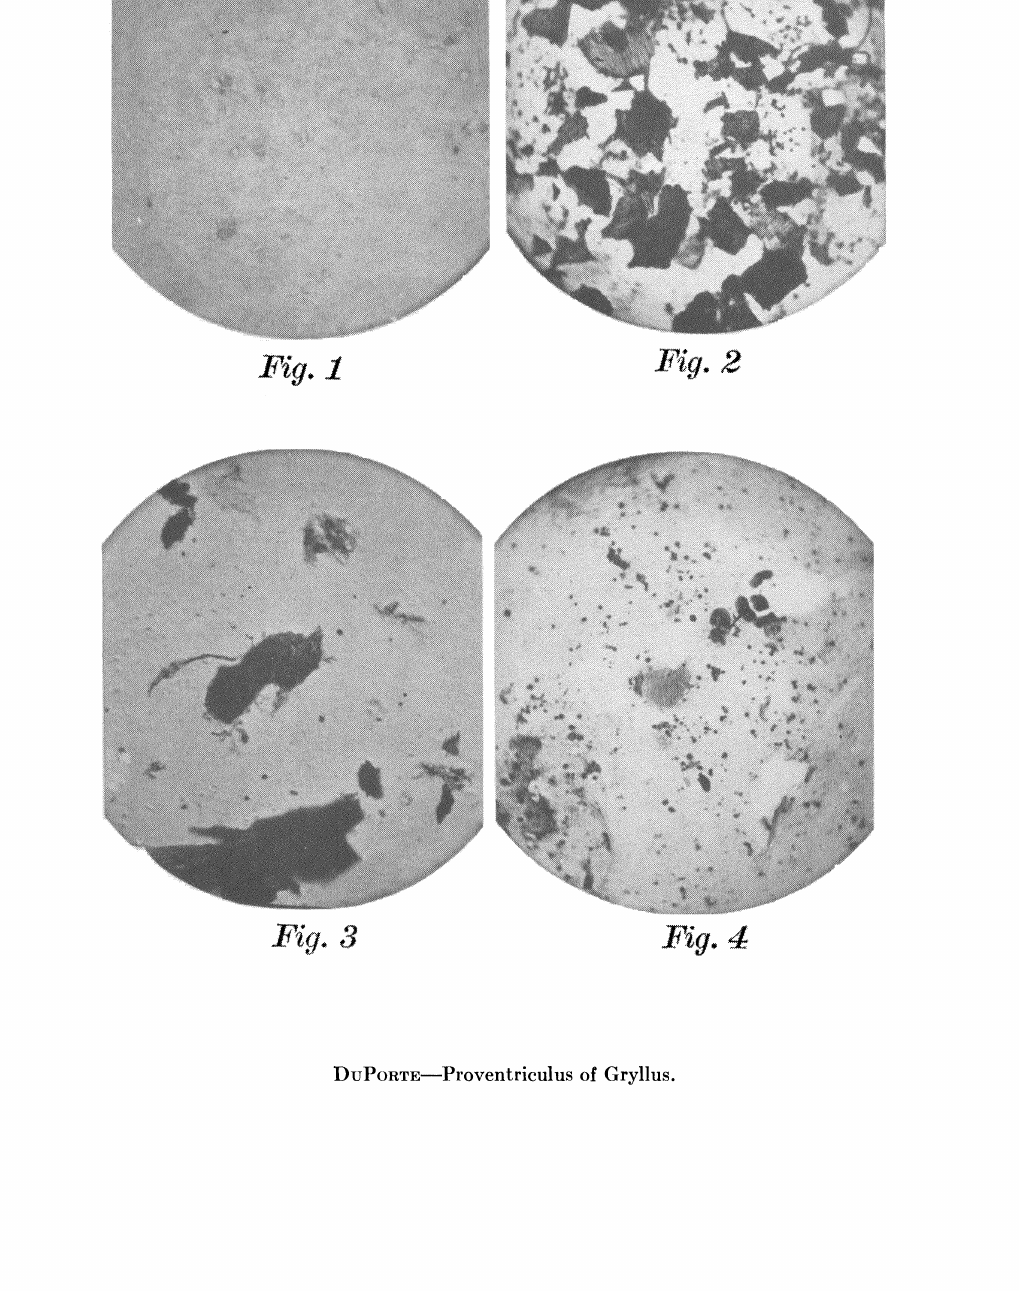
DuPoRTE--Proventriculus of